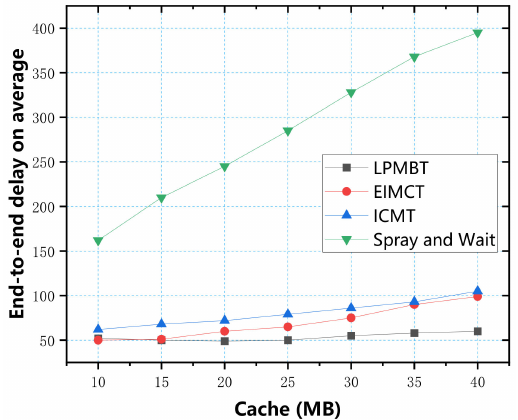
Figure 8. End-to-end delay on average.